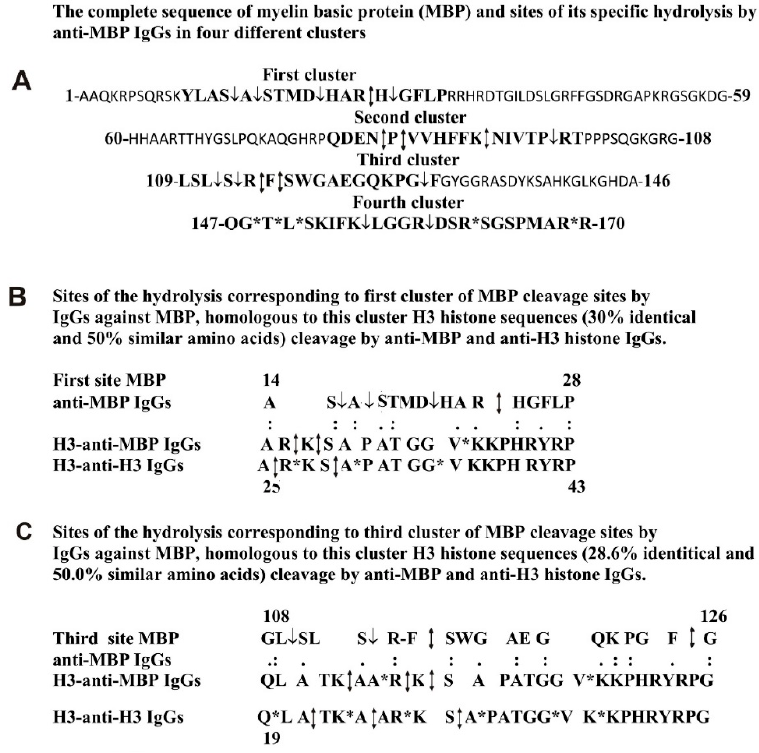
Figure 7. The complete sequence of human MBP and all sites of its hydrolysis in four clusters by anti-MBP IgGs ( A ). Analysis of homology between sequence of the first ( B ) and third ( C ) cleavage sites of MBP corresponding to anti-MBP IgGs with two sequences of H3 histone, which are homologous to these MBP clusters and hydrolyzed by both anti-MBP and anti-H3 histone IgGs. Major sites of the cleavage are marked by double arrows ( ↕ ), moderate ones by arrows ( ↓ ), and minor sites of the hydrolysis by stars (*) ( A – C ).